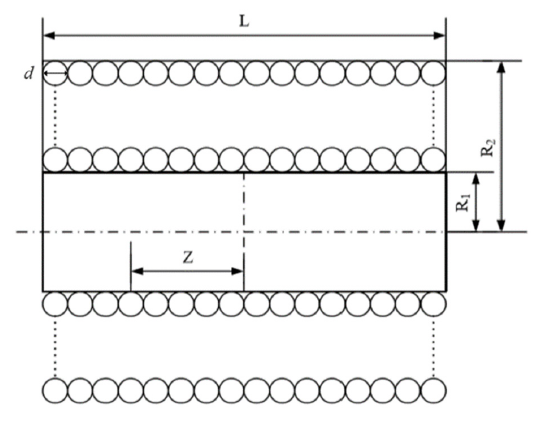
Figure 2. Schematic diagram of multilayer solenoid structure.